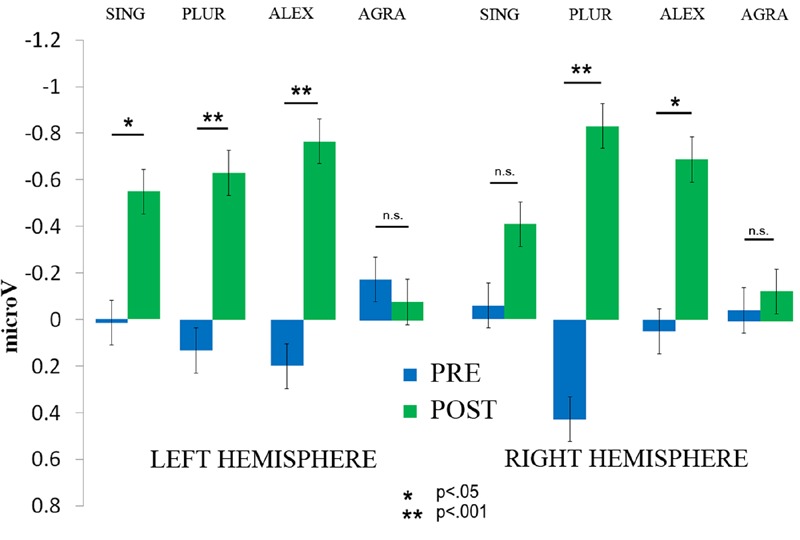
The significant interaction of Therapy session (post vs. pre) × Laterality × Sentence type is displayed. The amplitude of the MMN increased on the left hemisphere for the SING condition, albeit with marginal significance, and on both hemispheres for the PLUR and ALEX conditions. No increase was found for the AGRA sentence type. Error bars show standard errors.